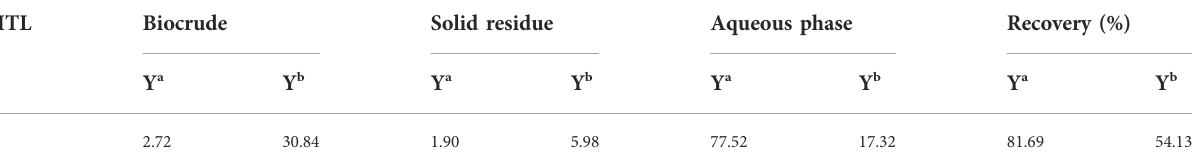
TABLE 3 C and N distribution (CD/ND, wt%) of products from continuous process at 350 ° C with 8 min retention time.